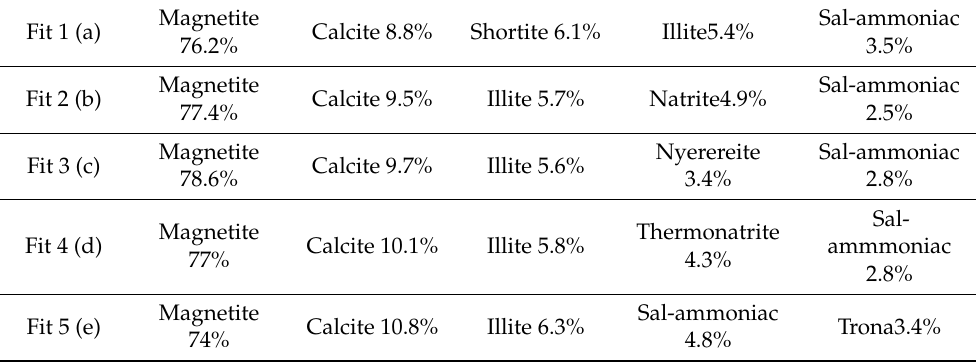
Table A2. Combination of minerals used to produce the